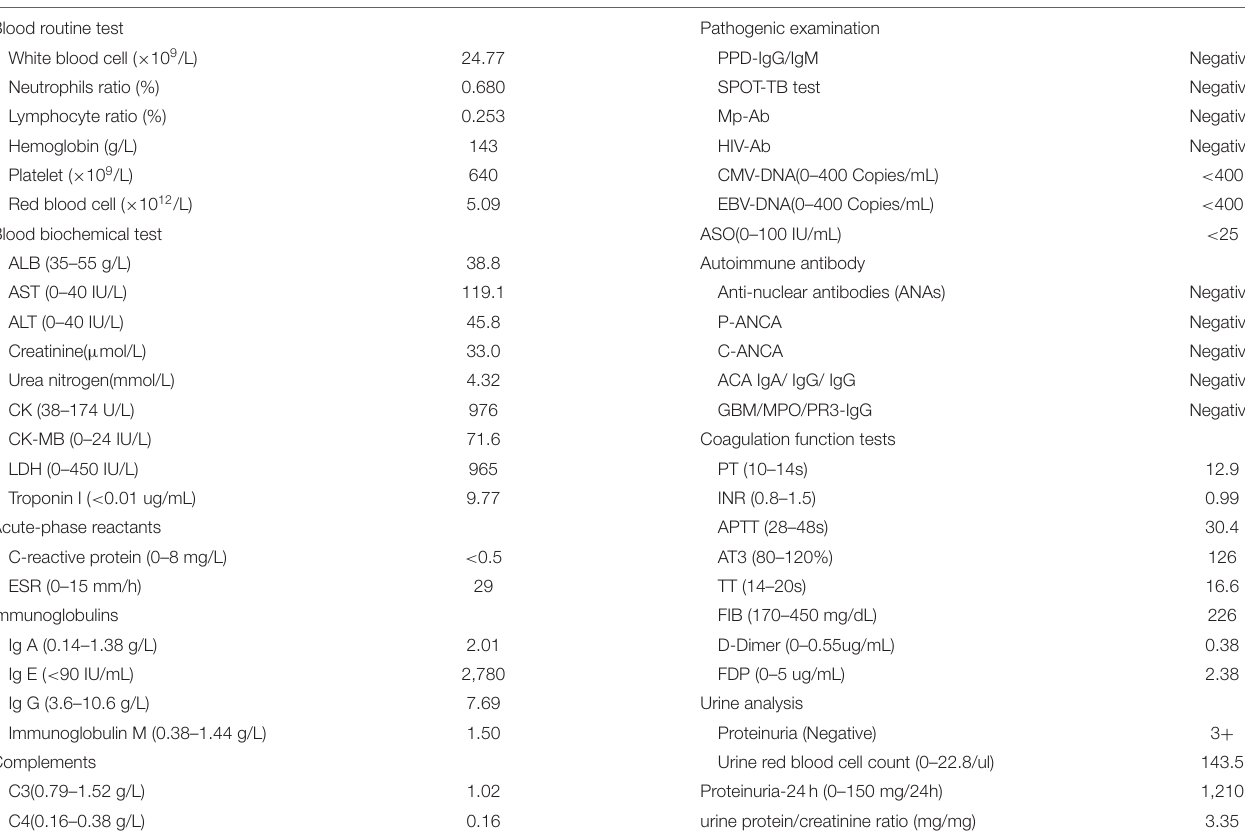
TABLE 1 | Laboratory examination results of the HSP/IgAV child after